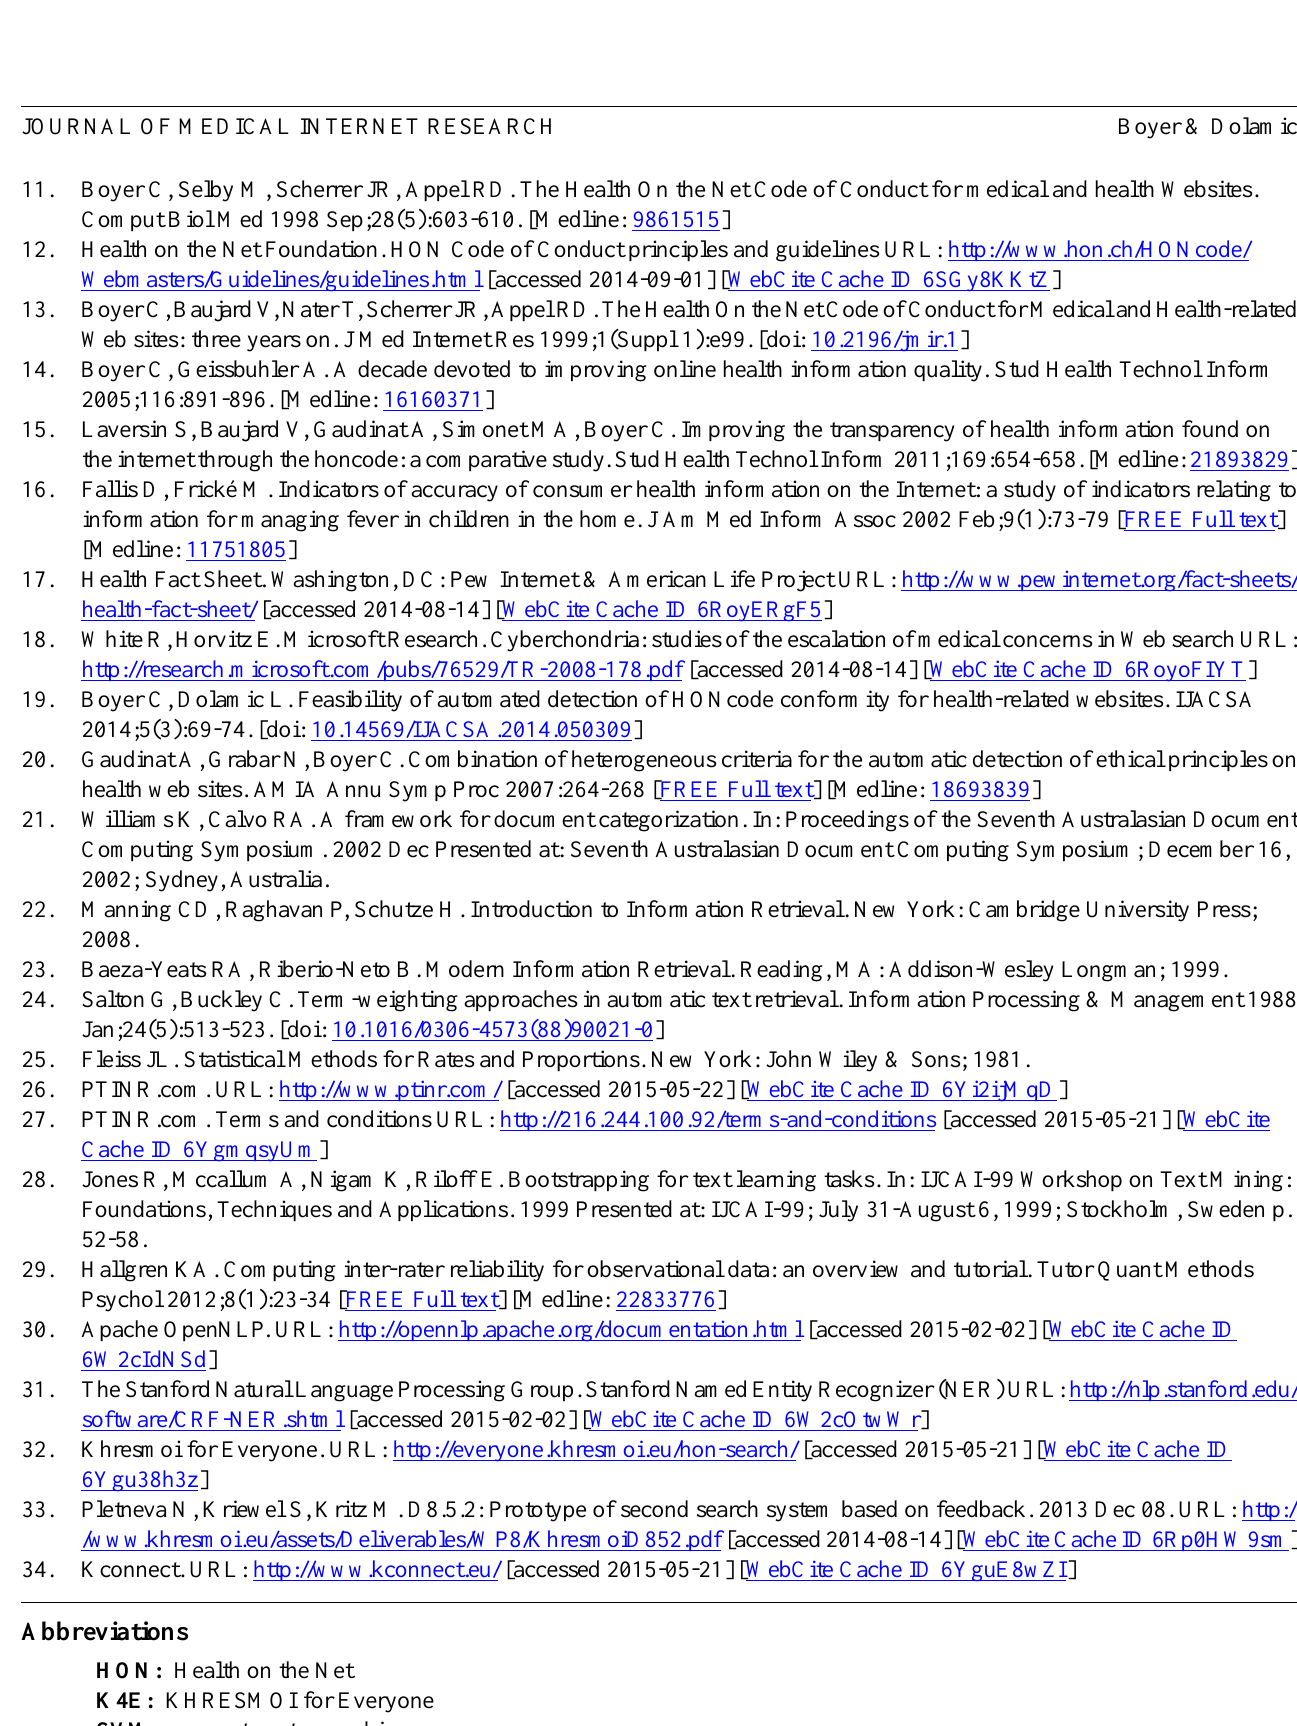
Abbreviations HON: Health on the Net K4E: KHRESMOI for Everyone SVM: support vector